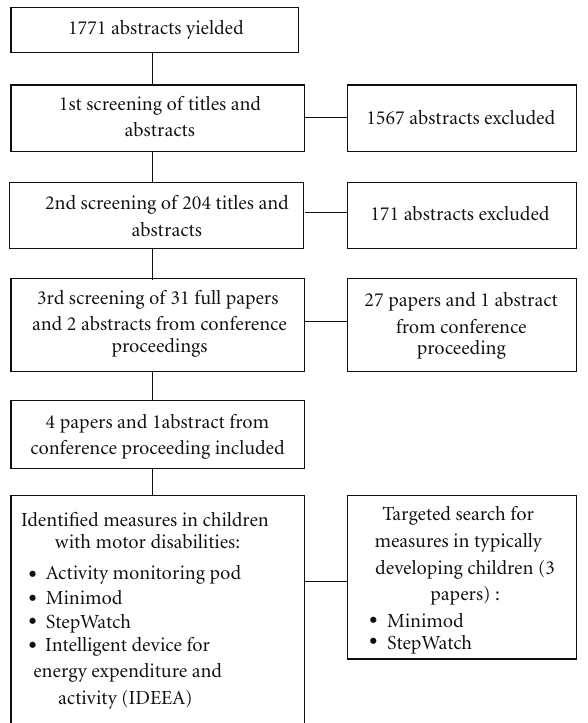
Figure 1: Flow diagram for search